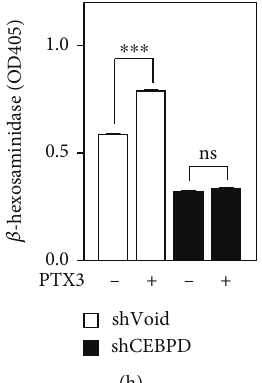
Figure 5: CEBPD is upregulated upon PTX3 treatment and contributes to degranulation and production of in fl ammatory mediators in mast cells. (a, b) Three-to-four-week-old female C57BL/6 mice ( n = 6 per group) were intraperitoneally sensitized and challenged with PBS or shrimp extract. Using Al(OH)3 as an adjuvant, shrimp allergy mice received shrimp extract plus Al(OH)3 in PBS i.p. on days 1, 4, 7, 10, 13, 16, 19, and 22. Blood was collected after the challenge on day 30 for the determination of IgE and PTX3 levels. Levels of serological total IgE and PTX3 were determined by ELISA. (c) E ff ects of PTX3 (300ng/ml) for 30 and 60 min on the mRNA levels of CEBPD in RBL-2H3 cells. (d) RBL-2H3 cells were stimulated with PTX3 (300ng/ml) for 30 and 60 min. Total lysates were harvested for western blot analysis using antibodies as indicated. (e) IgE-sensitized RBL-2H3 cells were stimulated with DNP-BSA plus PTX3 (300ng/ml) or not for 30min. Total lysates were harvested for western blot analysis using antibodies as indicated. (f) Serum-sensitized RBL-2H3 cells were stimulated with shrimp extract for 15min. Total lysates were harvested for western blot analysis using antibodies as indicated. (g) RBL-2H3 cells were infected with lentiviruses bearing shVoid or shCEBPD and treated with or without PTX3. Total RNA was harvested for qPCR assays. (h) β -hexosaminidase activity was determined as described in the Materials and